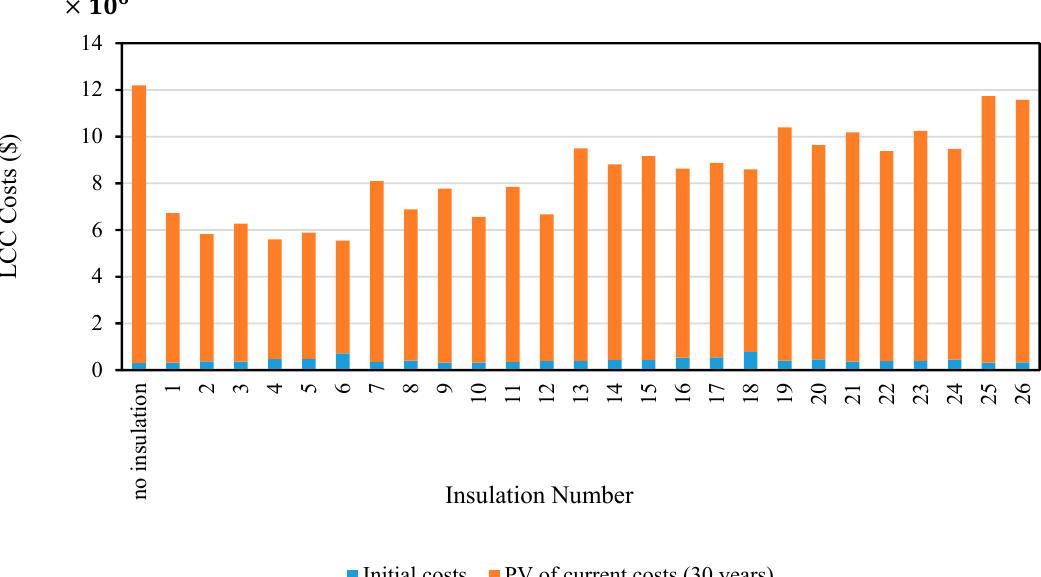
Figure 20. Comparison of the LCC for a 30-year period for different insulation scenarios based on Table 5.